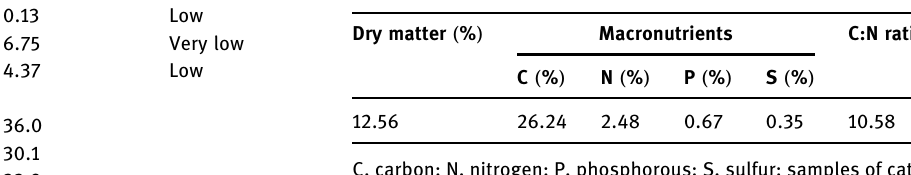
Table 2: Average dry matter and macronutrient contents of cattle manure applied to the experimental plots in 2017 and